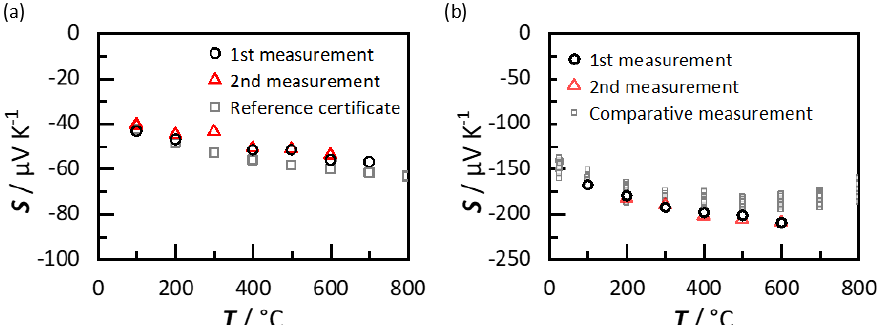
Figure 10. Measurement of the Seebeck coefficient up to 700 ◦ C: (a) Seebeck coefficient of constantan, a standard reference material; and (b) Seebeck coefficient of samarium-doped calcium manganite, a typical material for thermoelectric generators for high temperature applications.